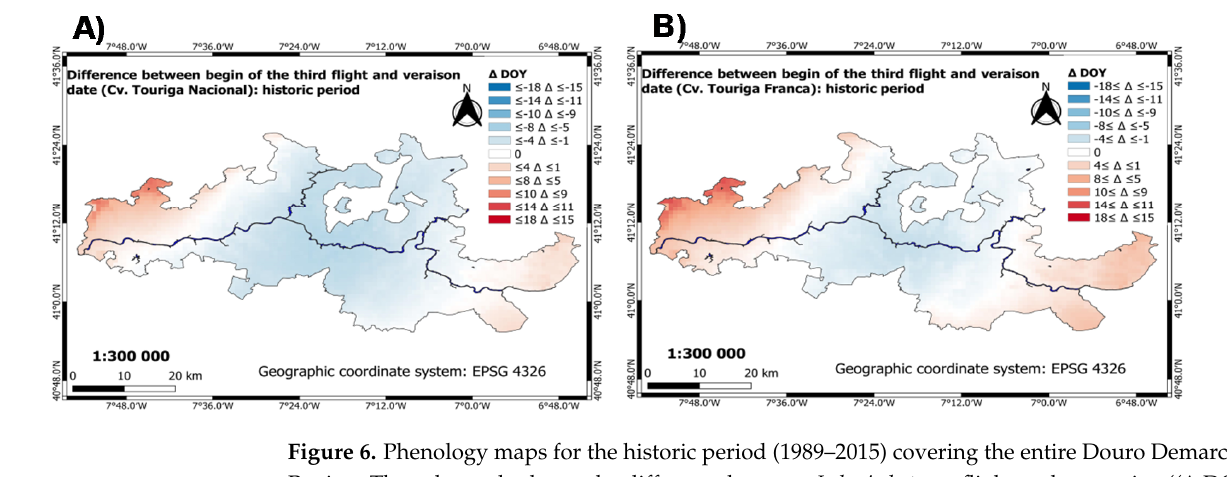
Figure 6. Phenology maps for the historic period (1989–2015) covering the entire Douro Demarcated Region. The color scale shows the difference between Lobesia botrana flight and grapevine (Δ DOY), namely third flight with veraison. In addition, the varieties under study are represented, cv. Touriga Nacional left; ( A ) and Touriga Franca right; ( B ). Lastly, the Douro river and main tributaries are also outlined (thick blue line).